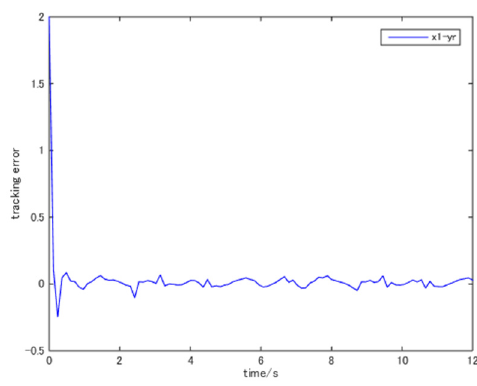
Figure 6. The trajectory of x 1 ( t ) − y r ( t ) .